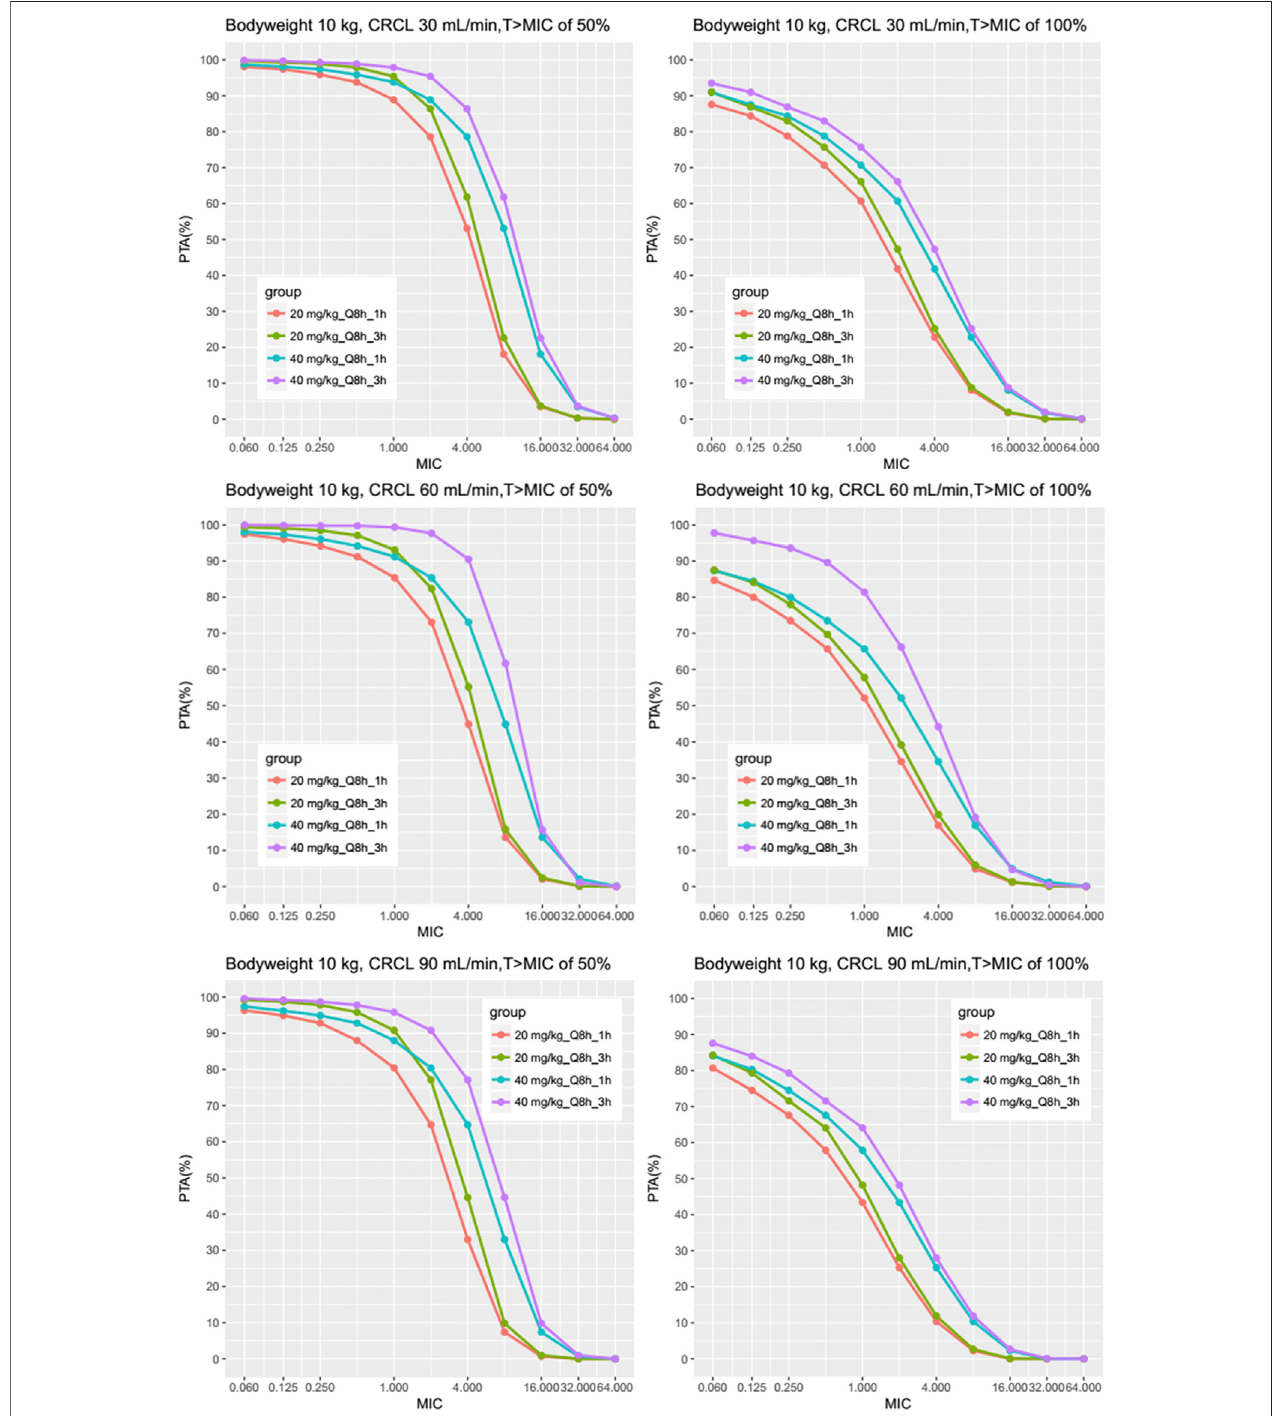
FIGURE 4 | Results of the Monte Carlo simulation with the fractional target attainments against a range of MICs for body weight 10 kg. The meropenem dosing regimens were as follows: 20 mg/kg every 8 h as a 1-h infusion, 40 mg/kg every 8 h as a 1-h infusion, 20 mg/kg every 8 h as a 3-h infusion by two steps as described previouslyand40 mg/kgevery8 hasa3-hinfusionbytwosteps.ResultsofdifferenteCRCLwereshownandthePTAwasevaluatedforMICsmainlybetween0.25and 16 mg/L.